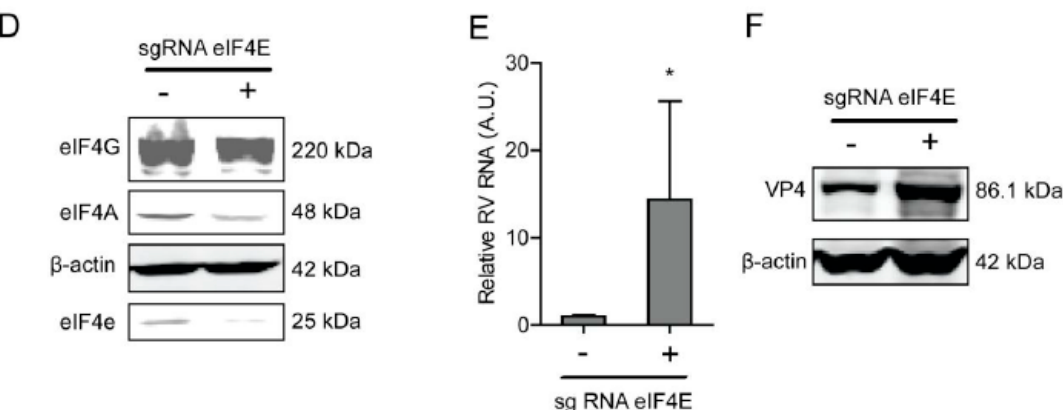
Figure 2. The eIF4E suppresses rotavirus infection. ( A ) Western blot assay measured the eIF4E protein